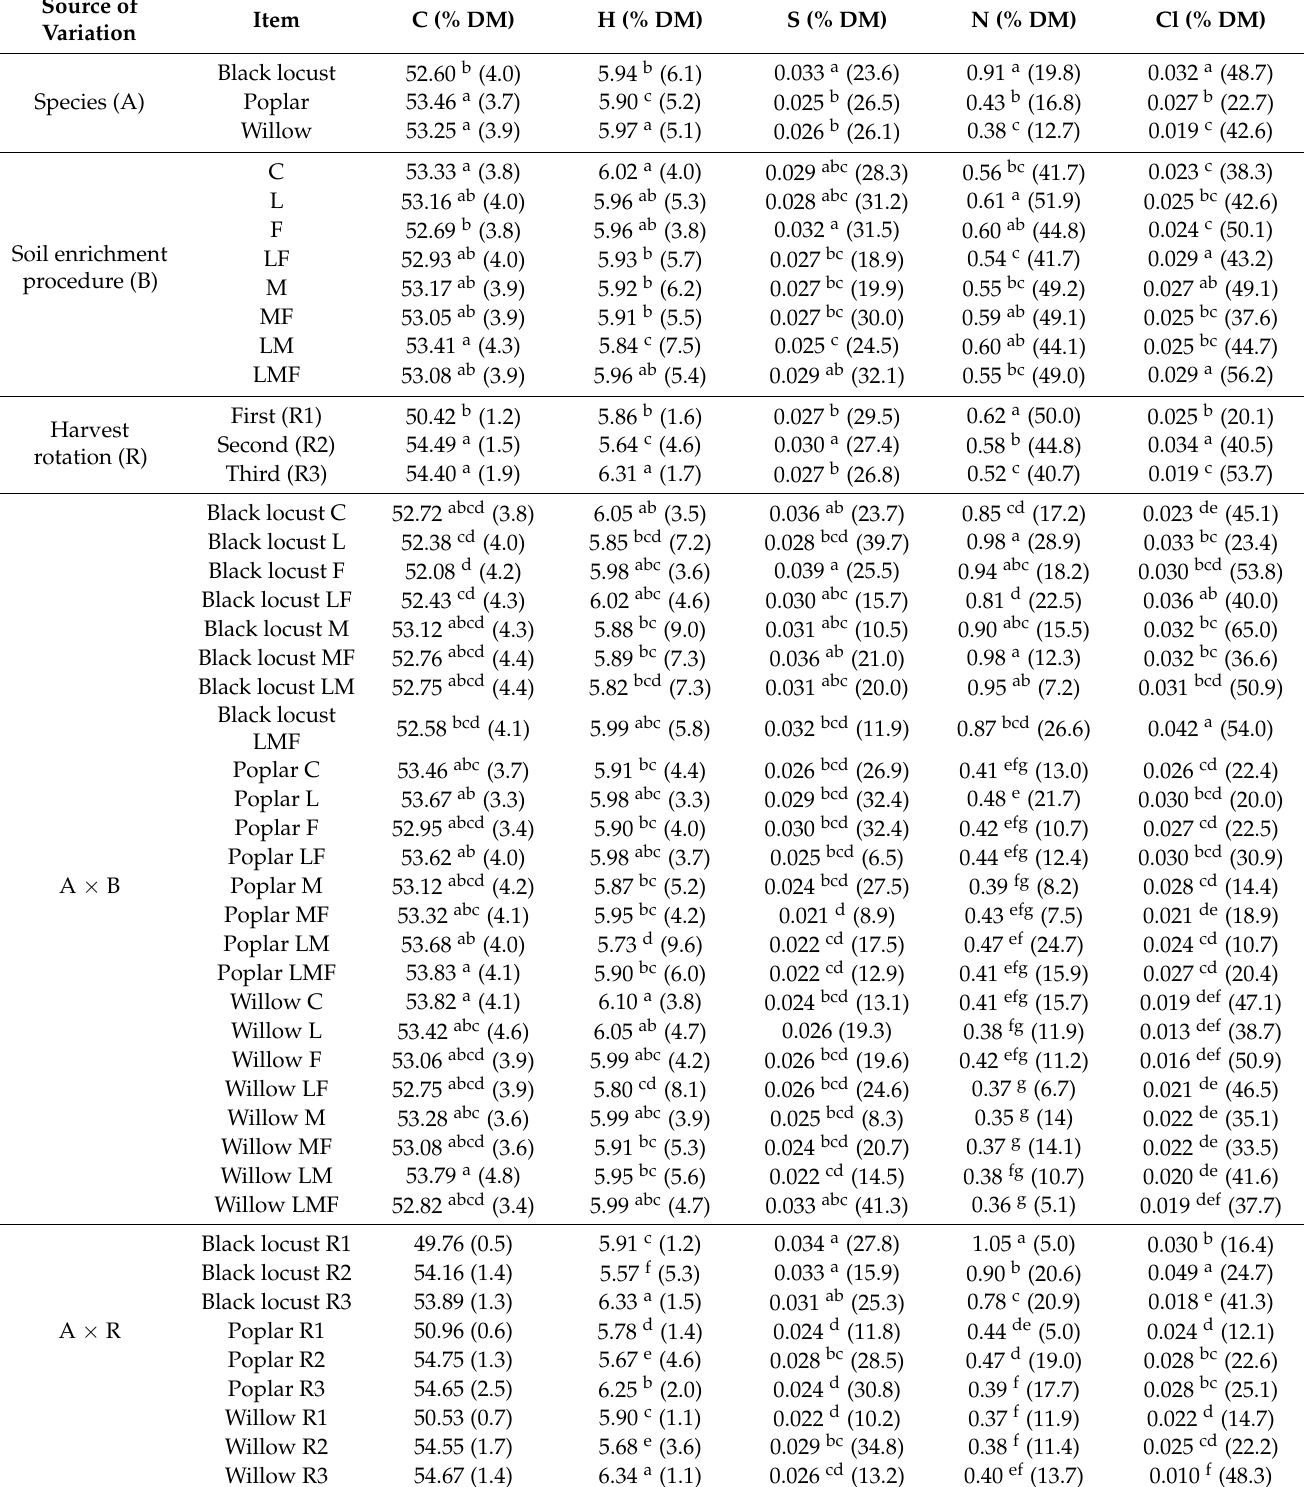
Table 4. The elemental composition of short-rotation woody crop (SRWC) biomass depending on the species and the soil enrichment procedure in three consecutive four-year harvest